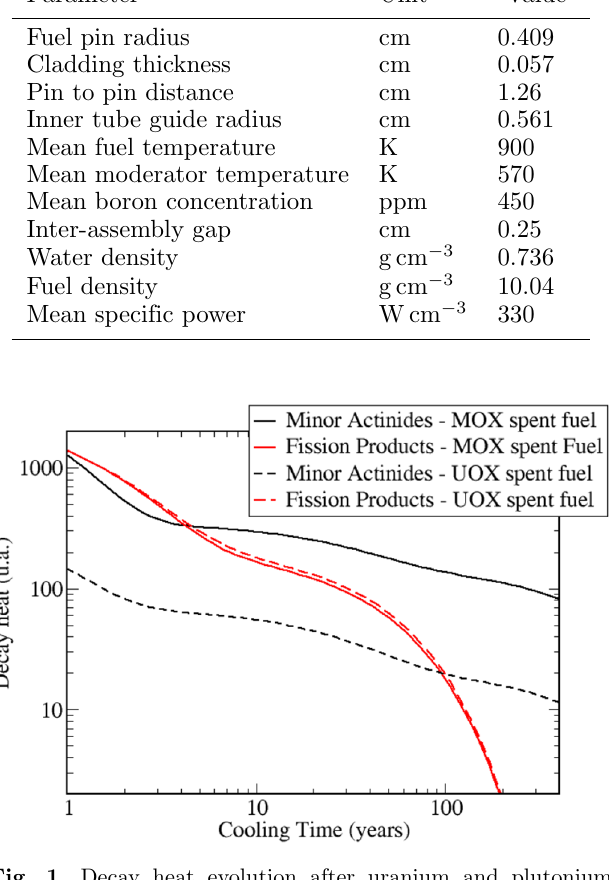
Fig. 1. Decay heat evolution after uranium and plutonium extraction.